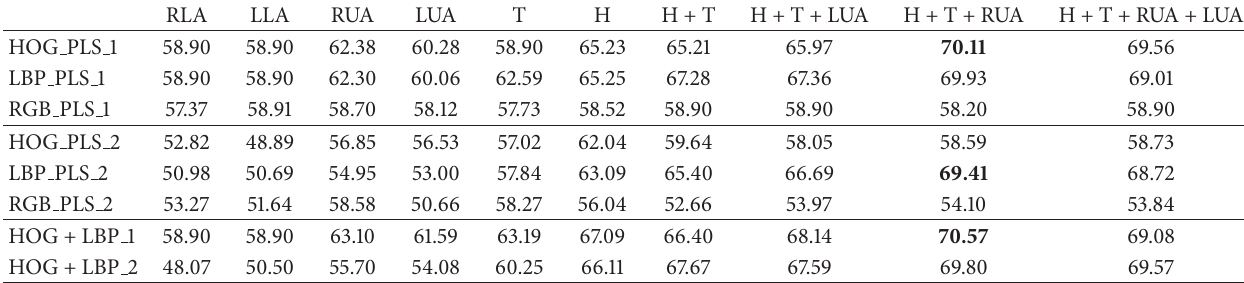
Table 5: Gender recognition accuracies (%) using the PLS method for dimensionality reduction (denoted by PLS 1) or both dimensionality reduction and classification (denoted by PLS 2) on PASCAL data with annotated body parts.